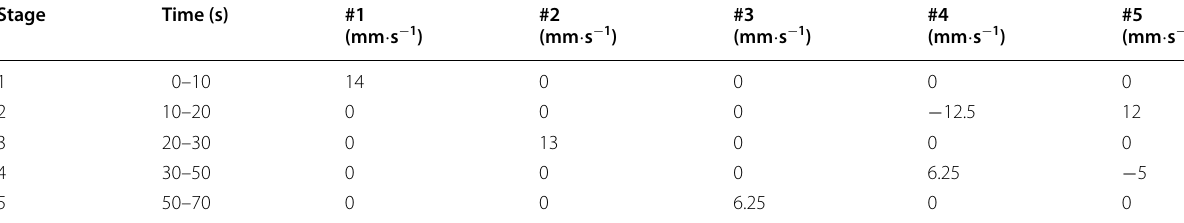
Table 6 Control parameters of each cylinder at different stages